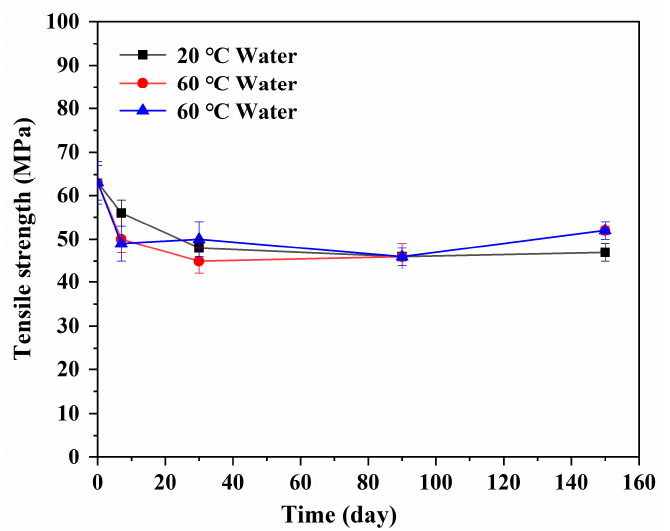
Figure 9. Tensile strength of epoxy resin immersed in distilled water or the alkali solution for different times.